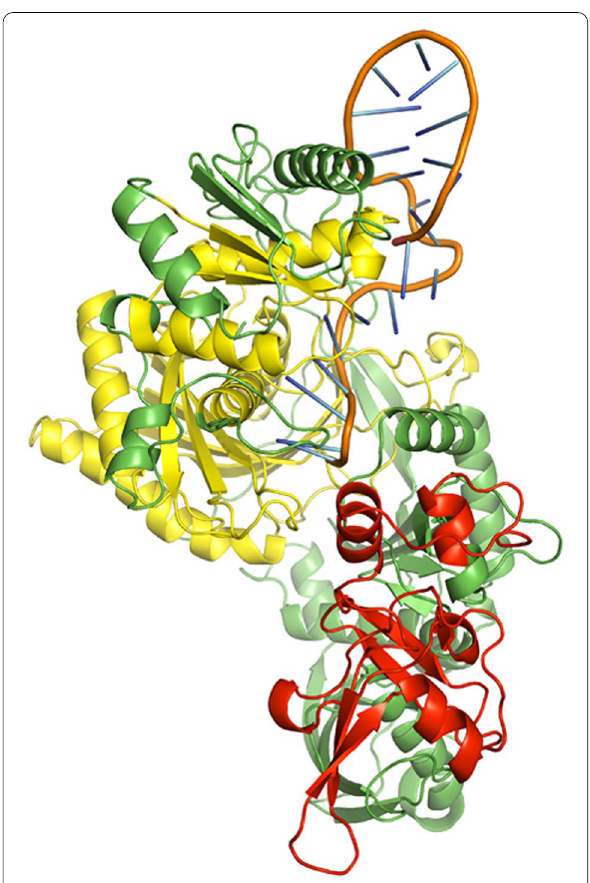
Fig. 3 A docked complex of AGO2 and M8.5. RNA, PAZ, PIWI, and the remaining regions are represented in orange, red, yellow, and green colors, respectively